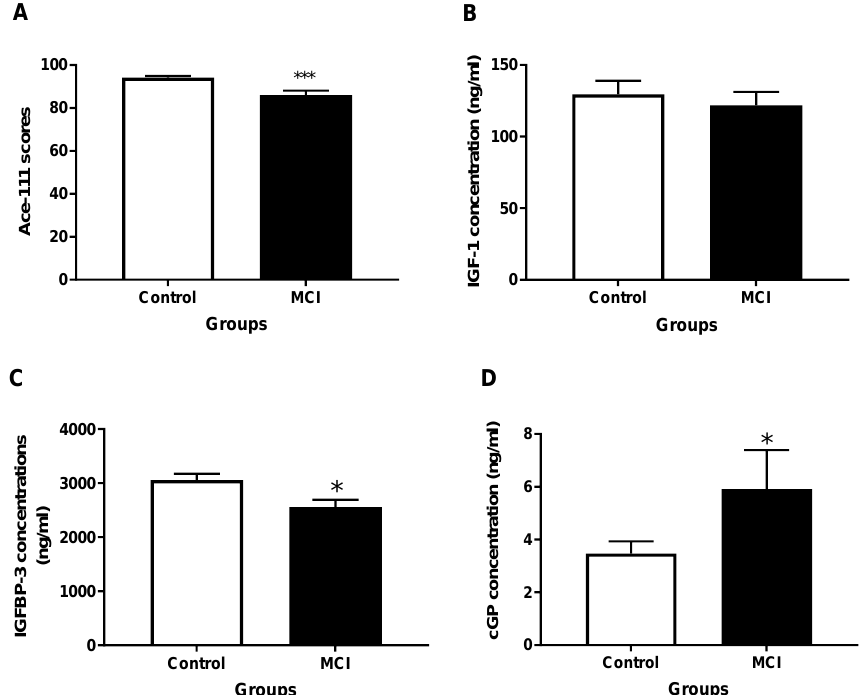
Figure 1. Changes in plasma concentrations of IGF-1 ( B ), IGFBP-3 ( C ), and cGP ( D ) in Alzheimer’s patients with mild cognitive impairment ( A ). The reduced IGFBP-3 and increased cGP concentra- tions represent a collective response to improve the bioavailability of IGF-1. * p <0.05, *** p